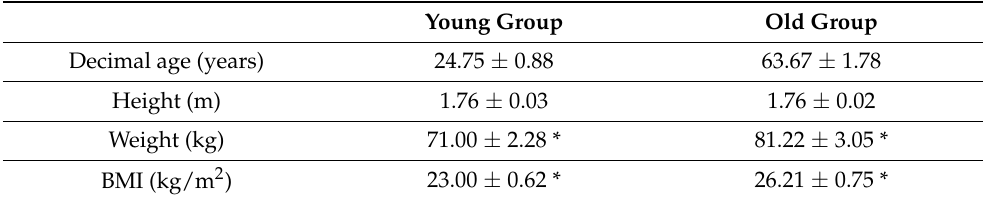
Table 1. Anthropometric parameters of the two experimental groups.